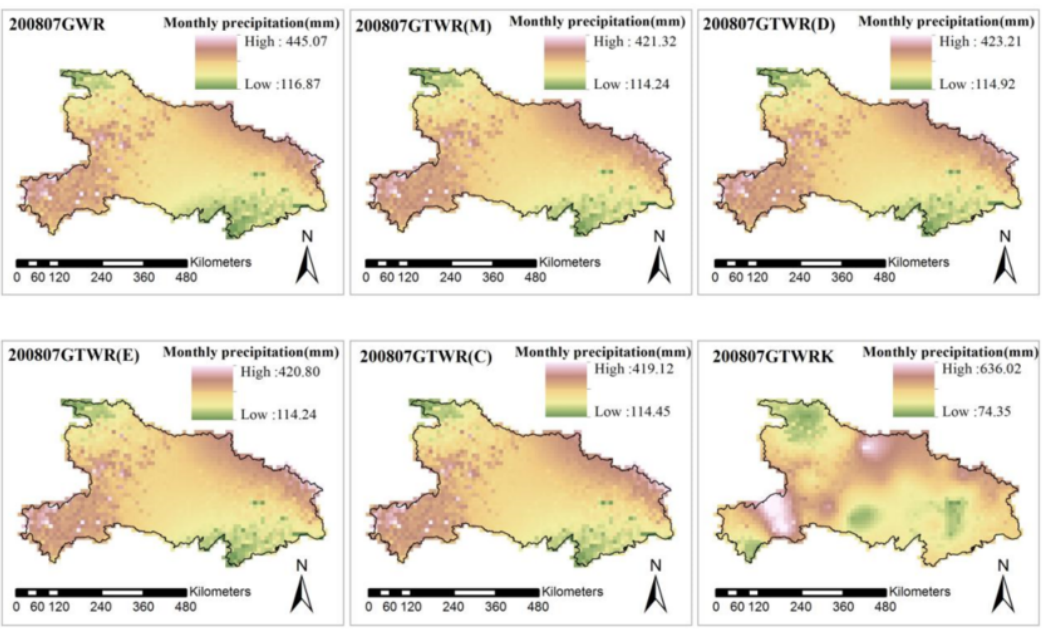
Figure 4. The fitting interpolation distribution map for geographically weighted regression (GWR), GTWR(M), GTWR(D), GTWR(E), and GTWR(C) corresponding to July